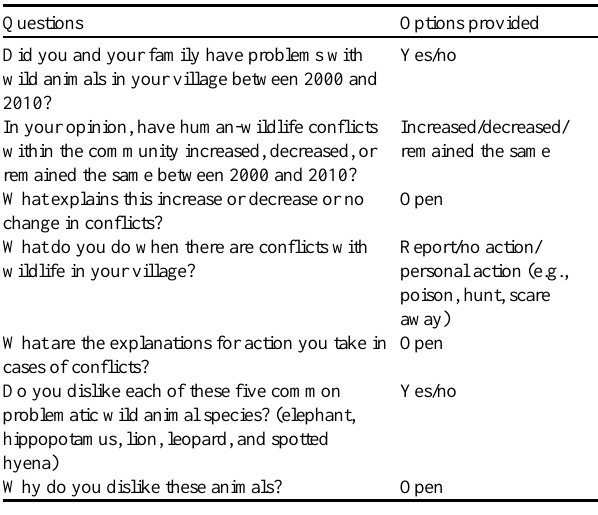
Table 2 . Selected survey questions and types of